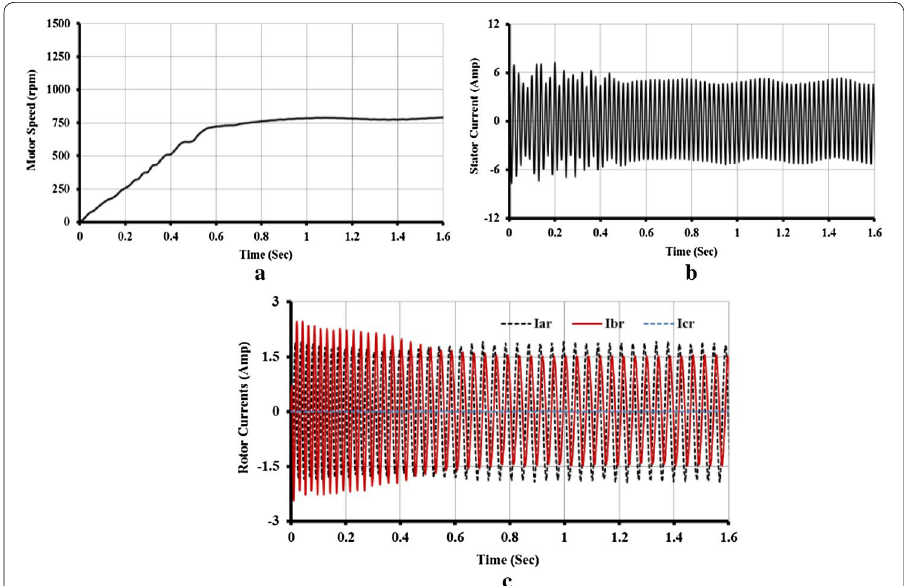
Fig. 8 Experimental results for standard delta connection with internal open circuit rotor phase, a motor speed, b stator phase current and c rotor